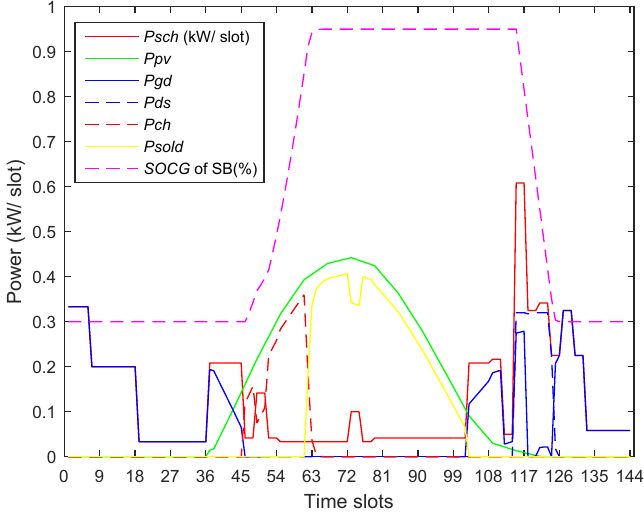
Figure 21. Load profile for minimal TBD using 2S-ToUP (Non-shifted) for PDDR-RED-based